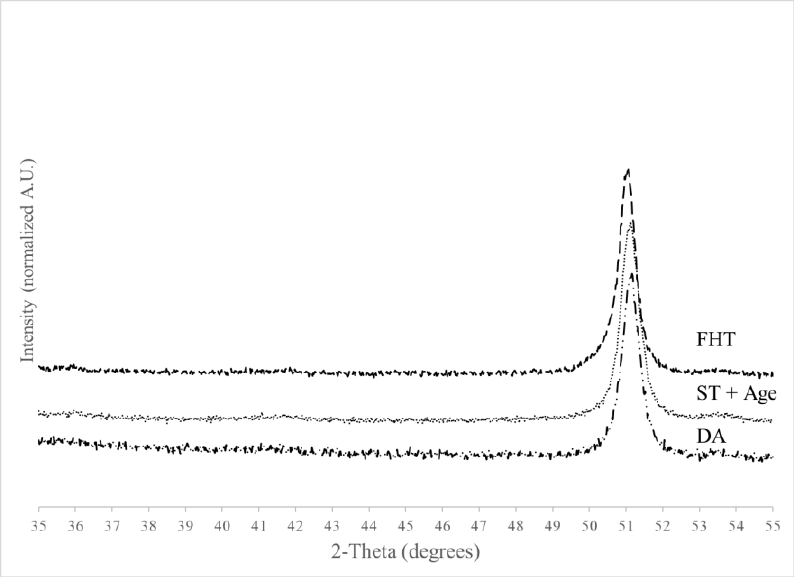
Figure 10. XRD analysis of Inconel 718 specimens after various heat treatments.